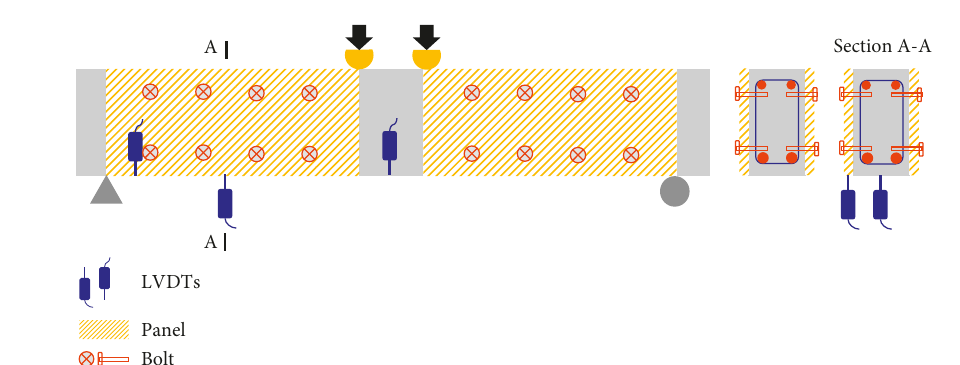
Figure 2: Details of the strengthened specimens and measurements (unit: